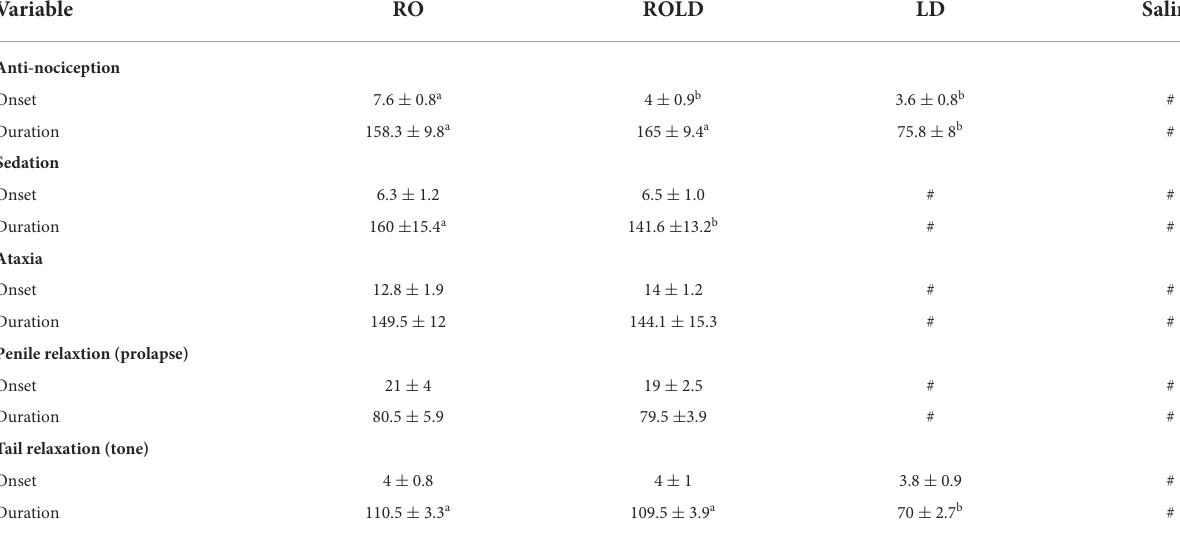
TABLE 2 Onset and duration of perineal anti-nociception, sedation, ataxia, tail relaxation (flaccidity) and penile prolapse (Mean ± Standard deviation) following epidural injection of RO ( n = 6), ROLD ( n = 6), LD ( n = 6), and ( n = 6) in